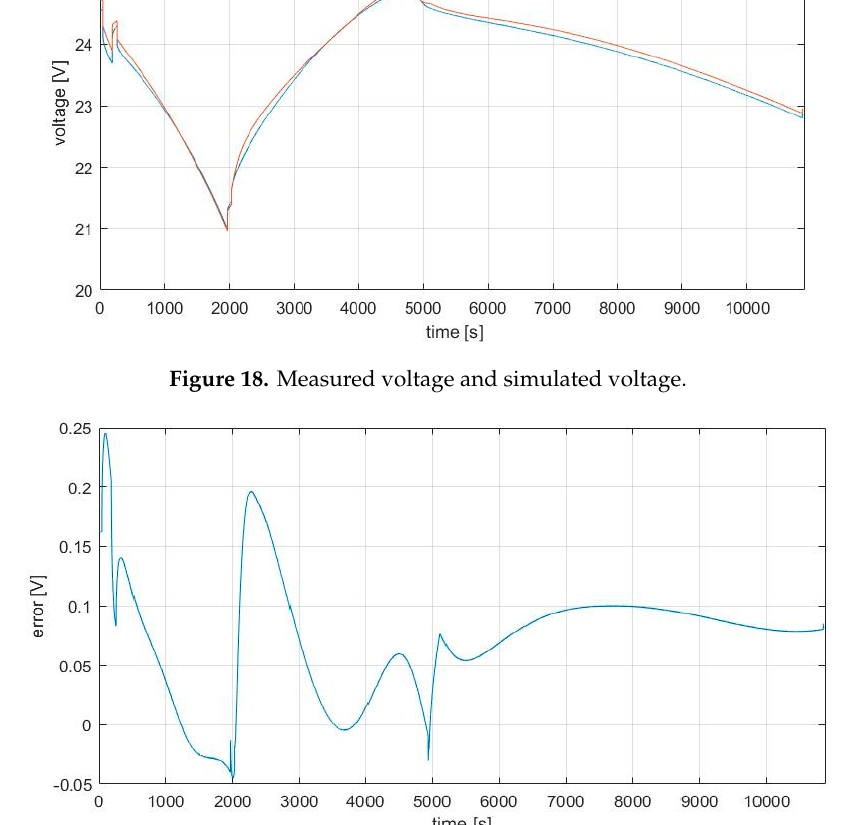
Figure 20. Measurement system block diagram.